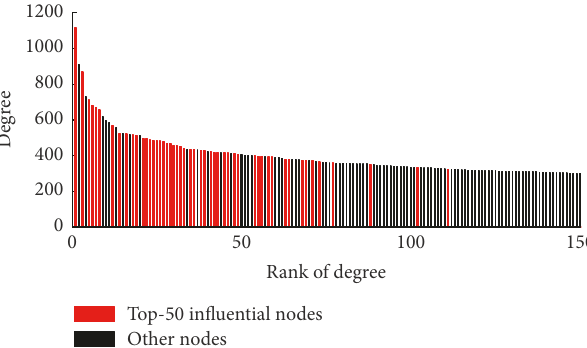
Figure 3: The relation between the influence spread and the degree in Facebook.